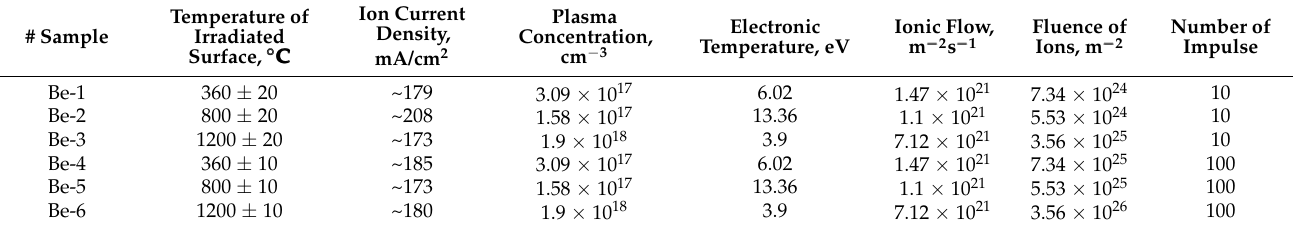
Table 1. Parameters for conducting experiments on the effect of hydrogen plasma on the beryl- lium